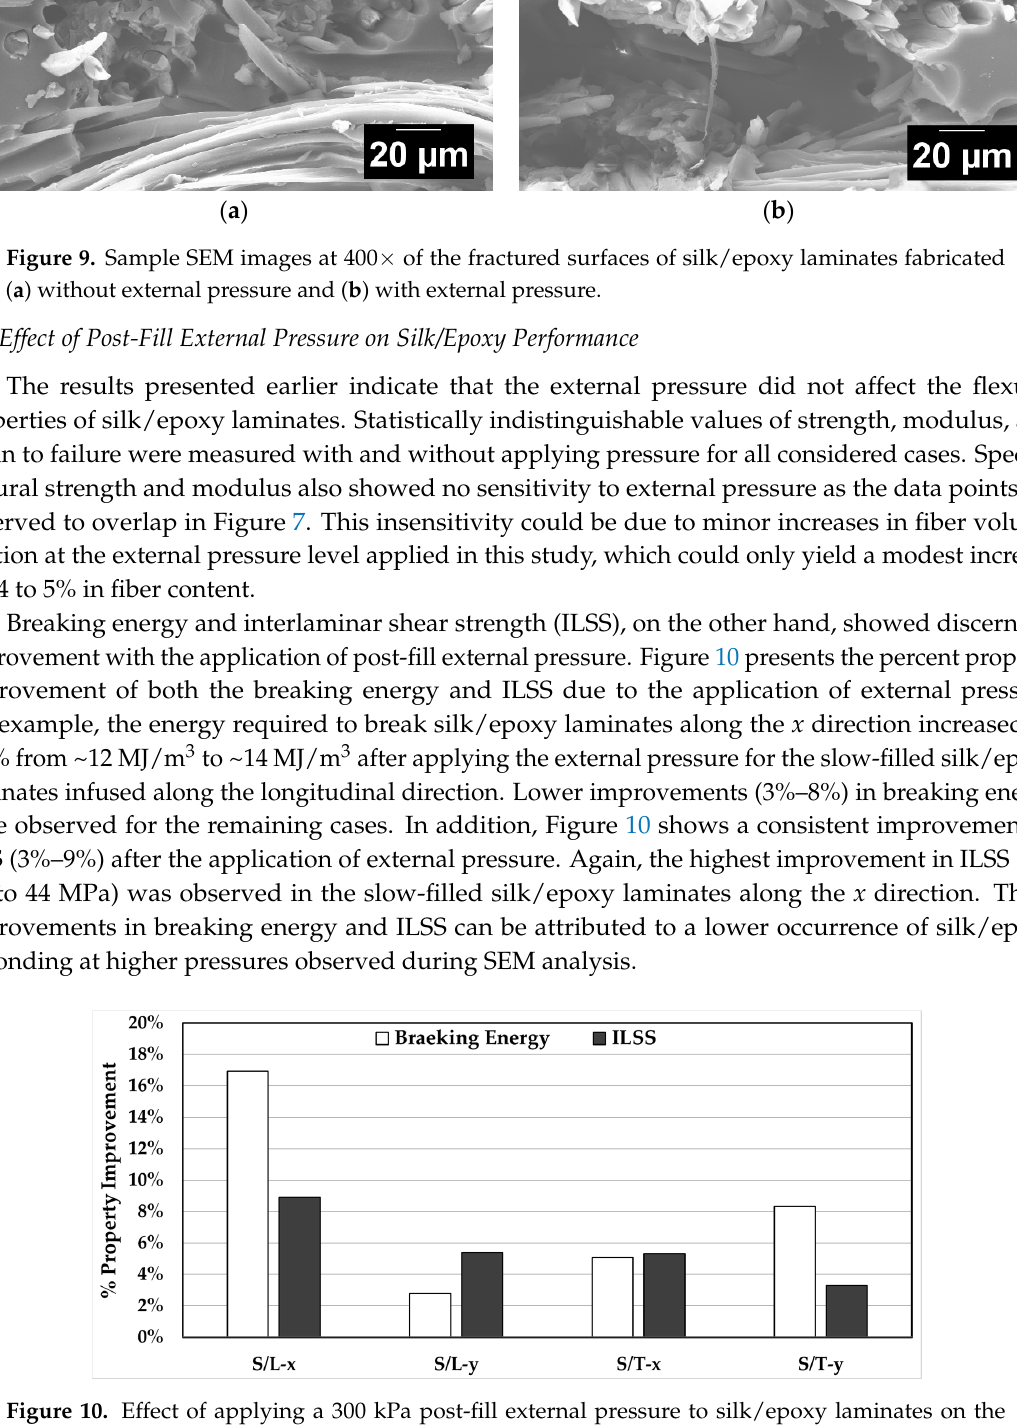
Figure 10. Effect of applying a 300 kPa post-fill external pressure to silk/epoxy laminates on the breaking energy and interlaminar shear strength (ILSS).